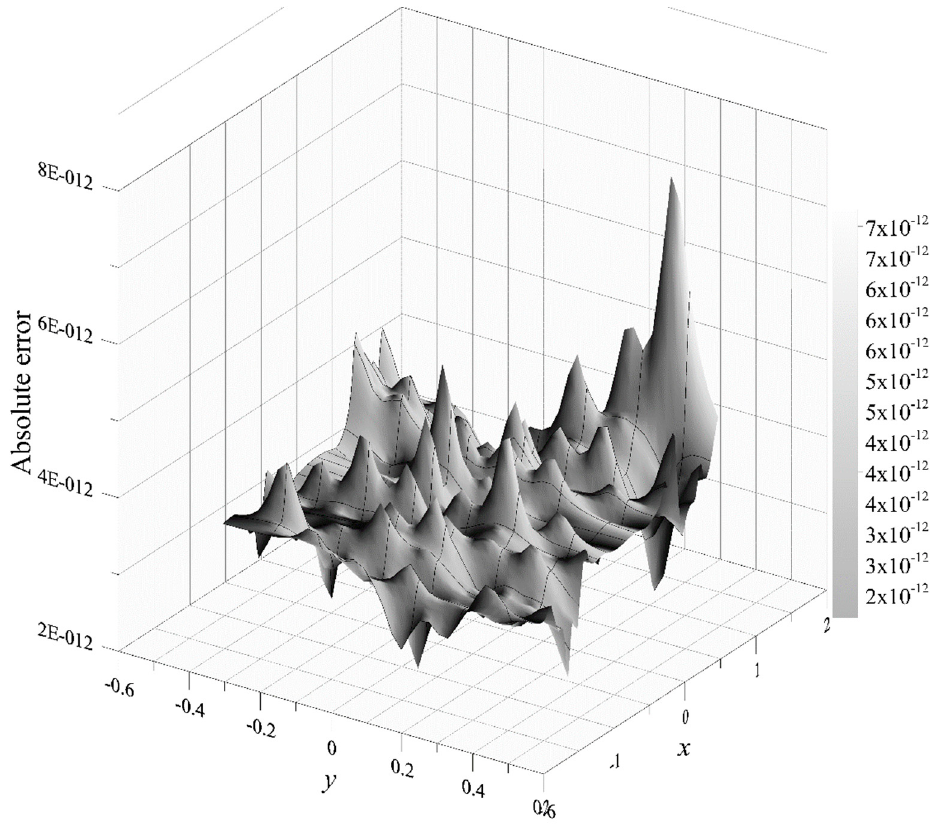
Figure 7. Absolute error of example 4.1.